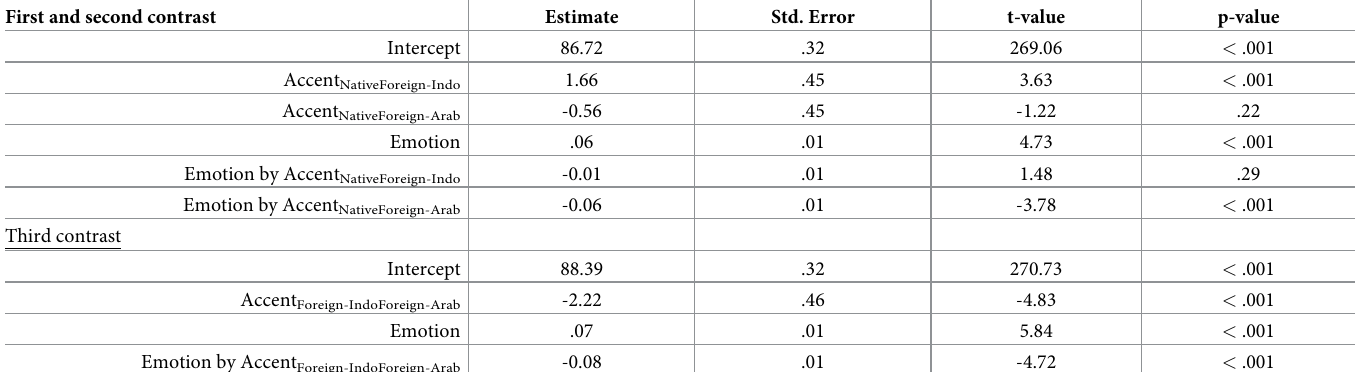
Table 9. Estimates, standard error, t-values, and p-values of the predictors Accent (Accent NativeForeign-Indo , Accent NativeForeign-Arab and Accent Foreign-IndoForeign-Arab ), Emotion (mean for anger, disgust, discomfort, sadness, and preoccupation), and their interaction on Respect for the first, second (top panel), and third contrast (bottom panel).